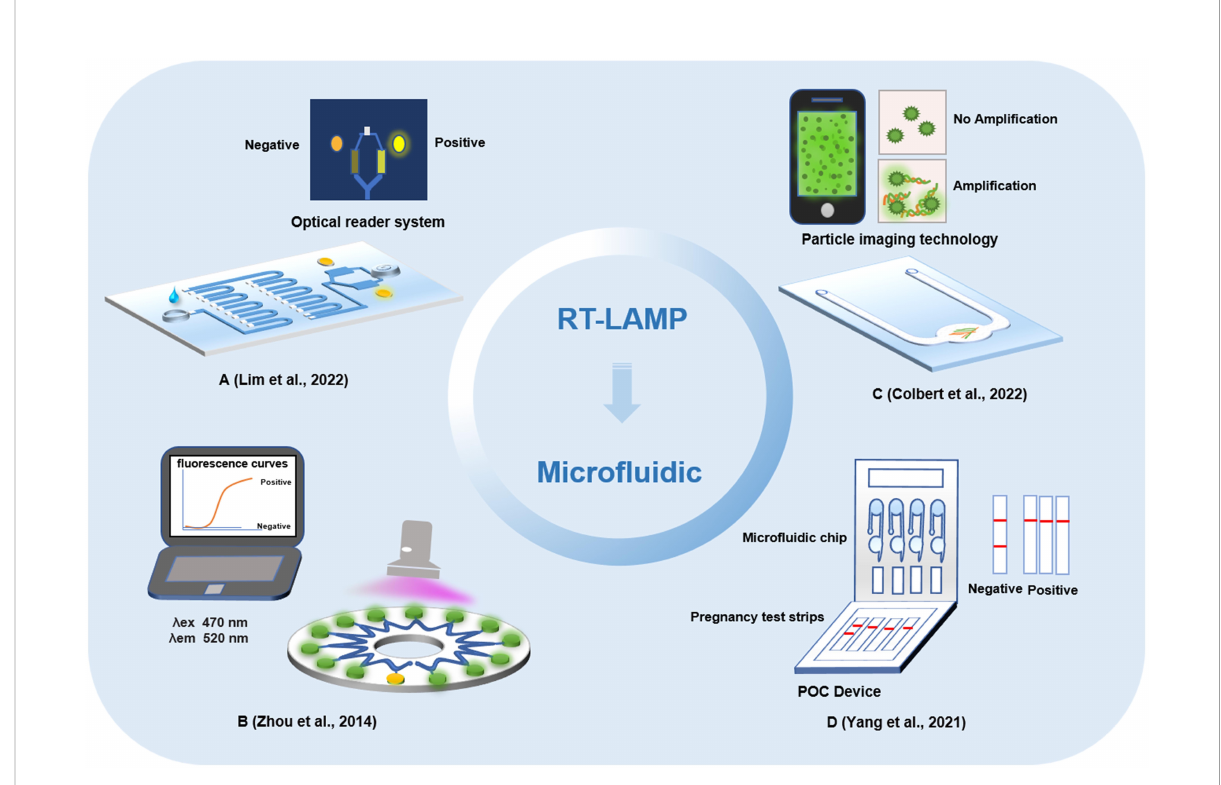
(C) Portable micro fl uidic chip based on particle imaging technique, particle diffusometry. (D) Micro fl uidic device based on commercial pregnancy test strips and a palm